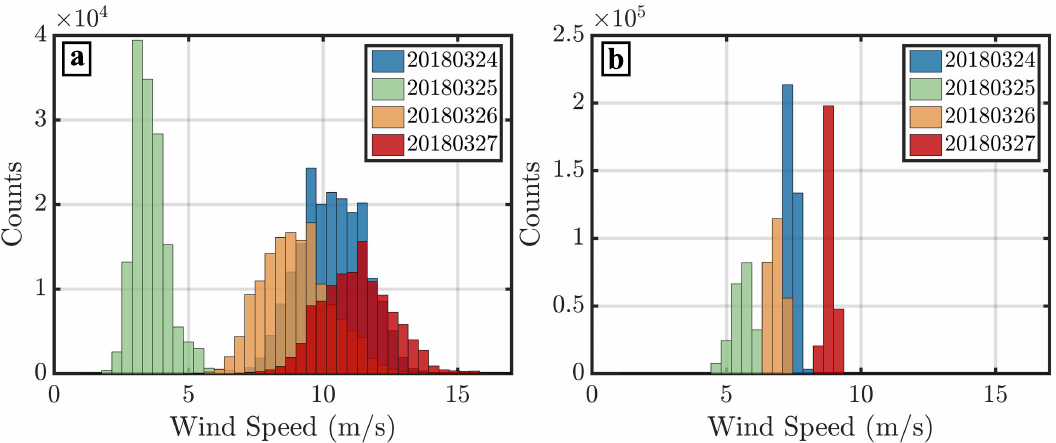
Figure 6. Histogram of wind speeds as measured by DopplerScatt ( left ) and NOAA Blended SeaWinds [19,20] ( right ) over the course of the four measurement